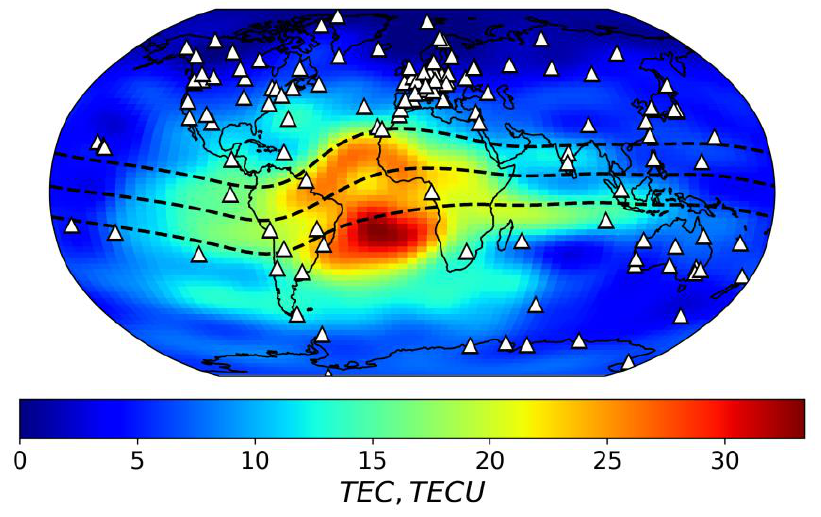
Figure 1. Global ionospheric map of TEC based on CODE data for 1 January 2008, at 16:00 UT. Dashed line indicates geomagnetic equator and geomagnetic parallels, triangles are GPS/GLONASS stations used to create the map.